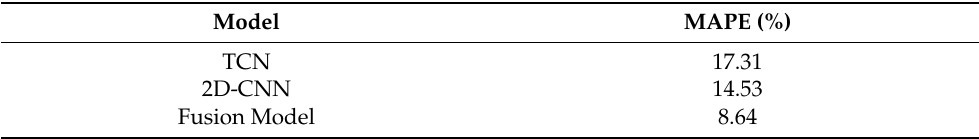
Table 7. The MAPE of seven nuclides predicted by each model at the final time